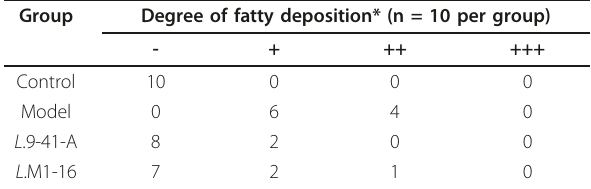
Table 3 Degrees of liver lipid deposition Group Degree of fatty deposition* (n = 10 per